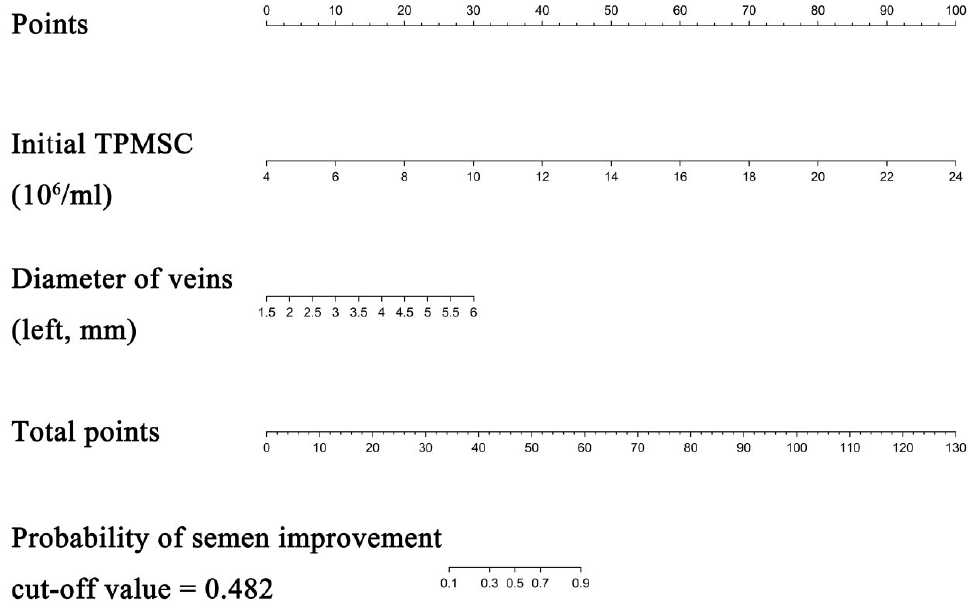
Figure 2. Nomogram to predict semen parameters improvement after MSV. Each clinicopathologic factor corresponds to a specific point by drawing a line straight upward to the Points axis. After summing the points located on the Total points axis, the sum represents the probability of semen parameters improvement after MSV by drawing a line straight down to the risk axis. Table 3. Multivariate binary logistic regression of semen parameter improvement after